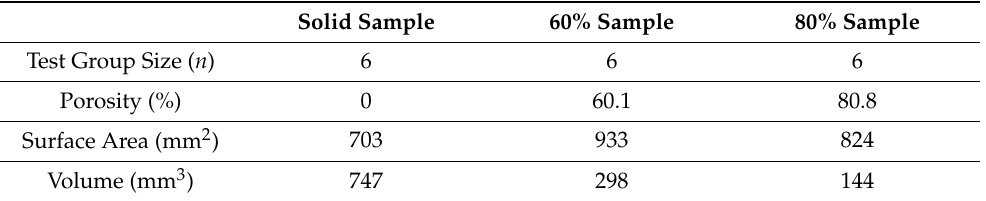
Table 1. Sample details derived from CAD (SolidWorks) for solid samples, 60% samples, and 80% samples with 25 mm by 10 mm by 5 mm external dimensions. Solid Sample 60%